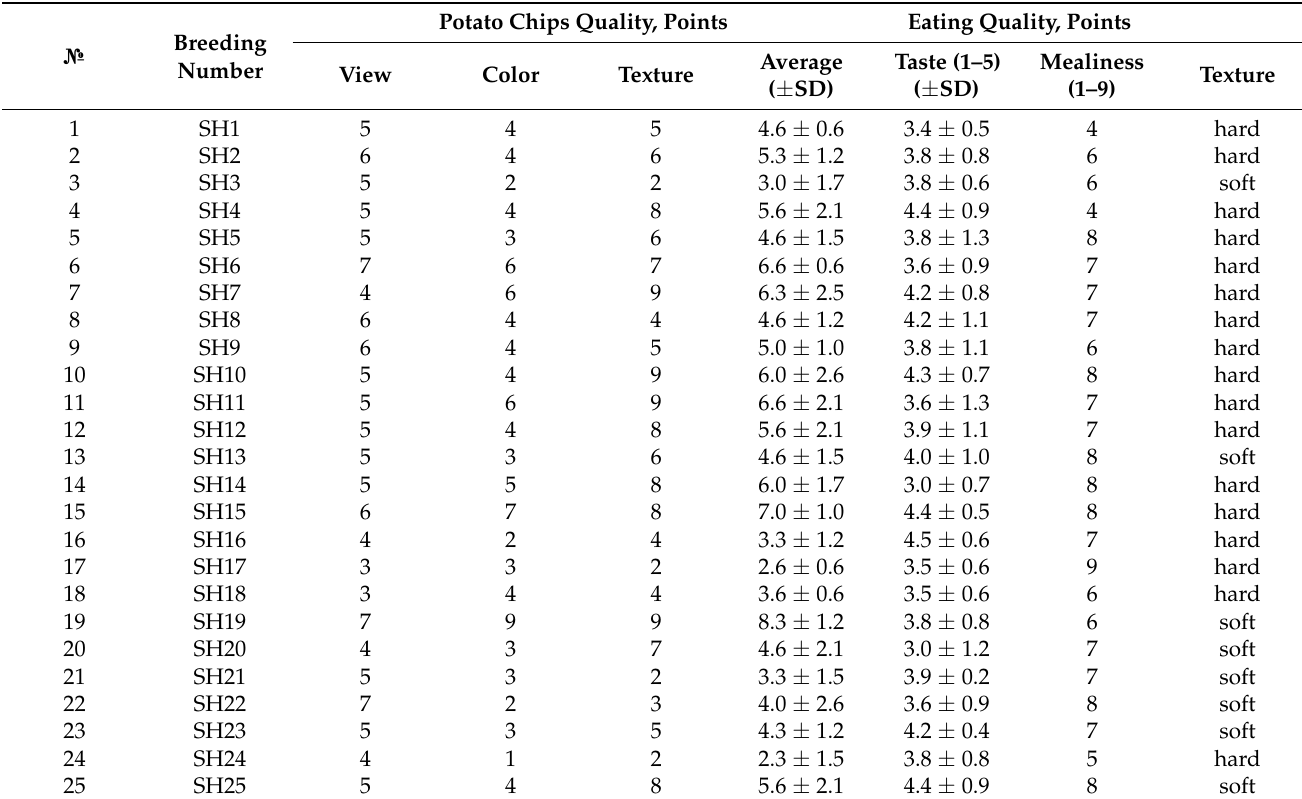
Table 8. Evaluation of potato chips quality and eating quality.